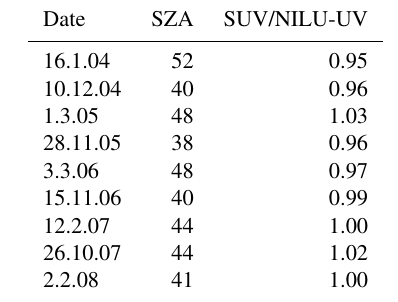
For the years 2000–2008 and 2010, all measurements at Ushuaia and Marambio were scaled according to the method described by Lakkala et al. (2005) and the erythemally weighted UV dose rates were calculated. The highest step between calibrations occurred in Marambio in January 2000 and was 11 % for erythemally weighted UV dose rates. A typical step between calibrations ranged from 1 % to 5 %